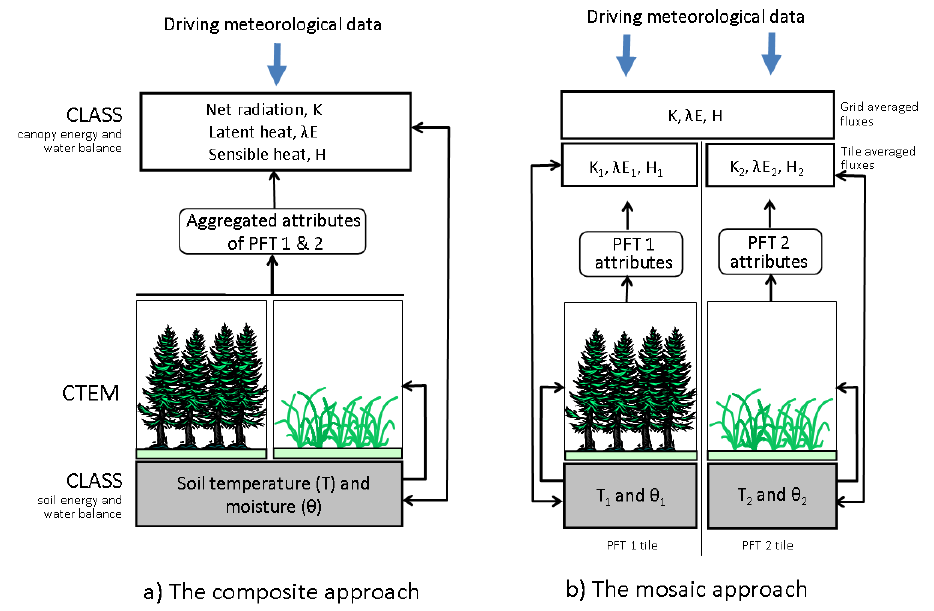
Figure 1. The coupling of the Canadian Land Surface Scheme (CLASS) and the Canadian 2 Fig. 1. The coupling of the Canadian Land Surface Scheme (CLASS) and the Canadian Terrestrial Ecosystem Model (CTEM) in the composite (a) and mosaic (b) Terrestrial Ecosystem Model (CTEM) in the composite (a) and the mosaic (b) approaches. 3